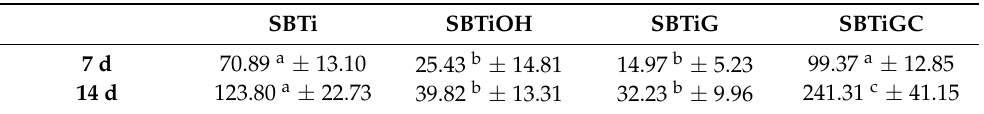
Table 2. ELISA analysis results, indicating the OPN expression level and mean ± SD (pg/mL) of test Scheme 7. and 14 d (groups with different letters are significantly different ( p < 0.05).